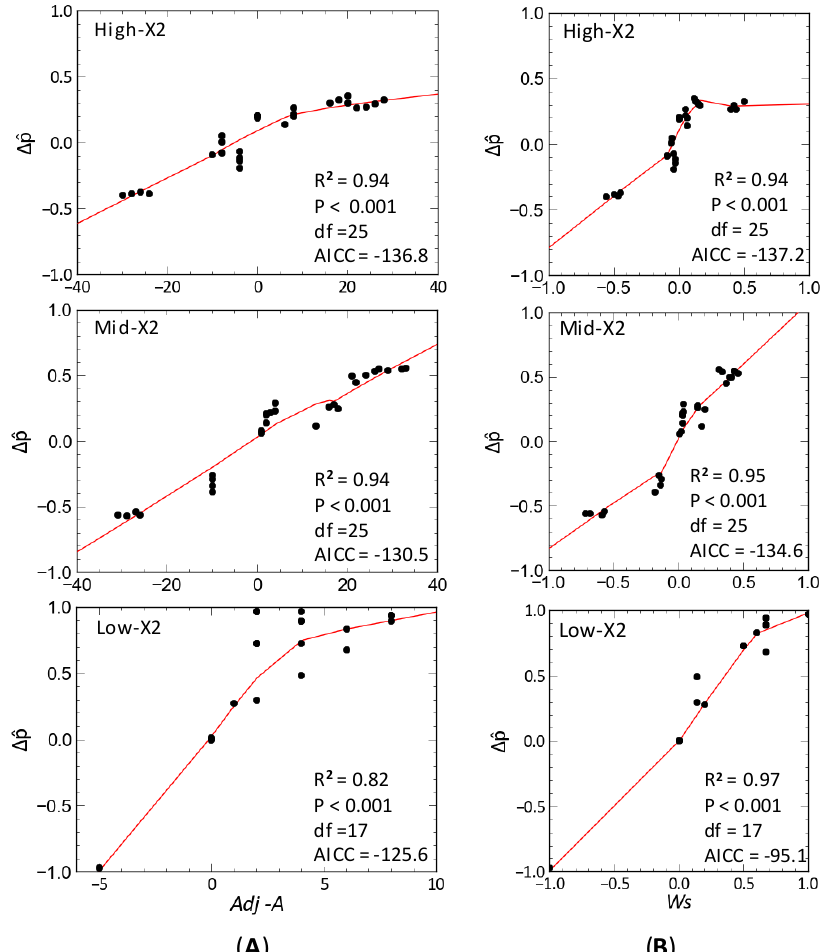
Figure 7. Relations between the net proportion of positive and negative Adj − A in stable quantitative models ( ∆ ˆ p ) at low-, mid-, and high-X2 positions and: ( A ) the estimated direction of change of corresponding variables in qualitative models ( Adj − A ); ( B ) the signed weighted feedback in qualitative models ( Ws ), as indicated for modeled subsystems in the low salinity zone at low-, mid-, and high-X2 positions.